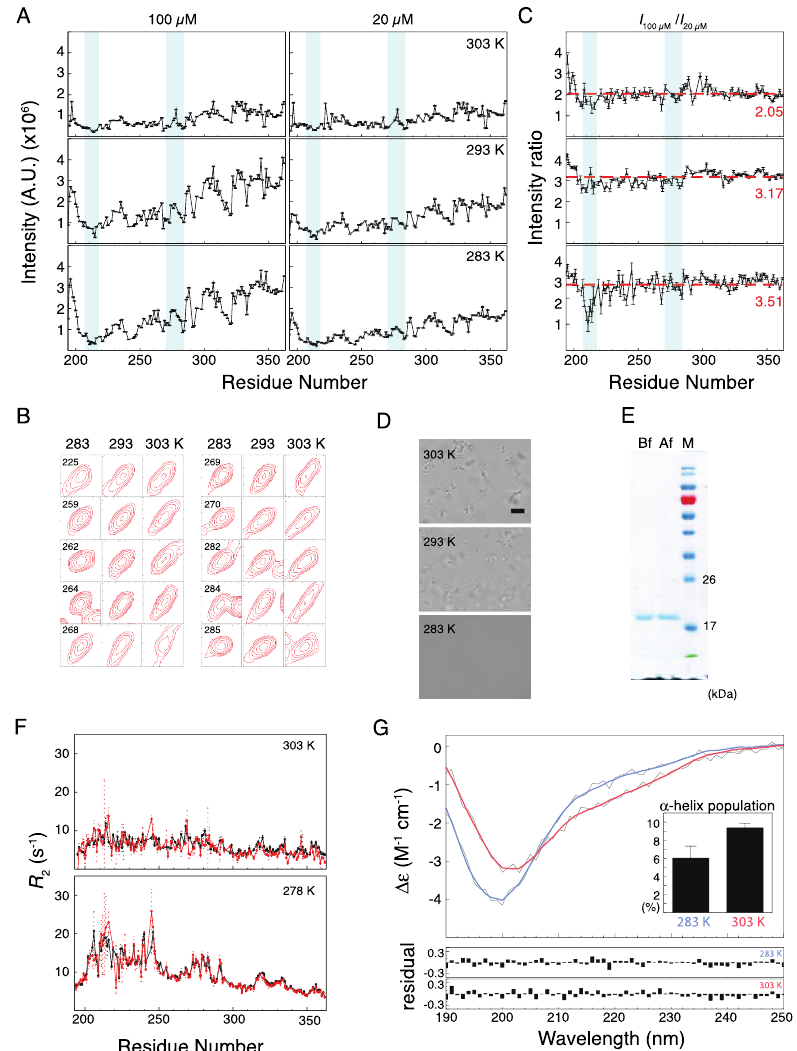
Figure 3. Temperature and concentration dependence of Musashi-1 oligomerization. ( A ) NMR HSQC peak intensities measured at two concentrations (100 and 20 µ M) and three temperatures (283, 293, and 303 K) at pH 5.5. Regions with α -helical propensity are shaded blue. ( B ) Selected peaks showing evidence of line-broadening with increasing temperature. The residue number is indicated on the left-upper corner in each panel. ( C ) Peak intensity ratios between 100 and 20 µ M samples. The numbers (red) indicate the averaged values. ( D ) Micrographs of the oligomers formed at 293 and 303 K (scale bar = 10 µ m) of 20 µ M samples. ( E ) SDS-PAGE analysis of protein integrity before (Bf) and after (Af) having increased the temperature above the oligomerization threshold. ( F ) Transverse relaxation rate constants ( R 2 ) at 278 and 303 K for 20 µ M (red) and 100 µ M (black) samples. ( G ) Circular dichroism spectra for 20 µ M samples (pH 5.5) at 283 K (blue) and 303 K (red) fitted using the BeStSel algorithm (gray lines: raw data). The inset compares the average α -helical populations at the two temperatures (three repeats; mean ± SD). Fitting residuals are shown in the lower